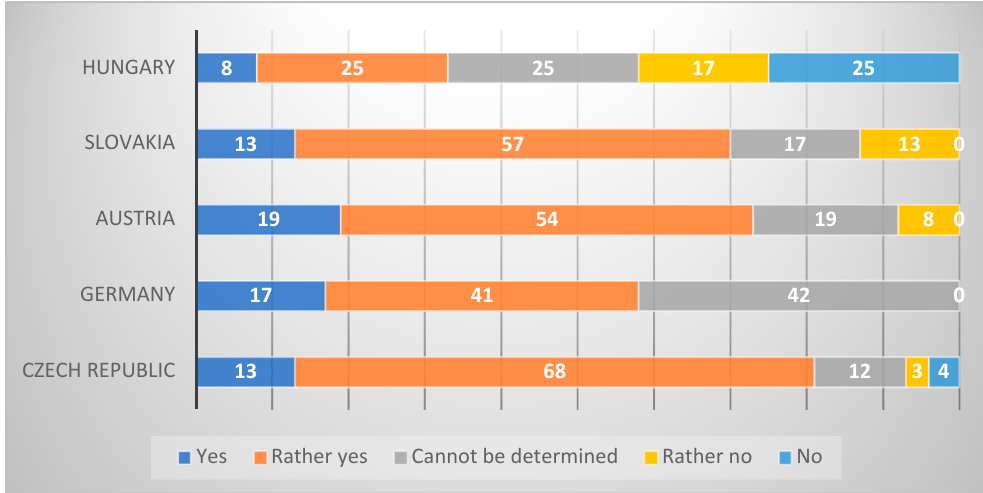
Figure 6. Success of change implementation by country (subjective assessment).